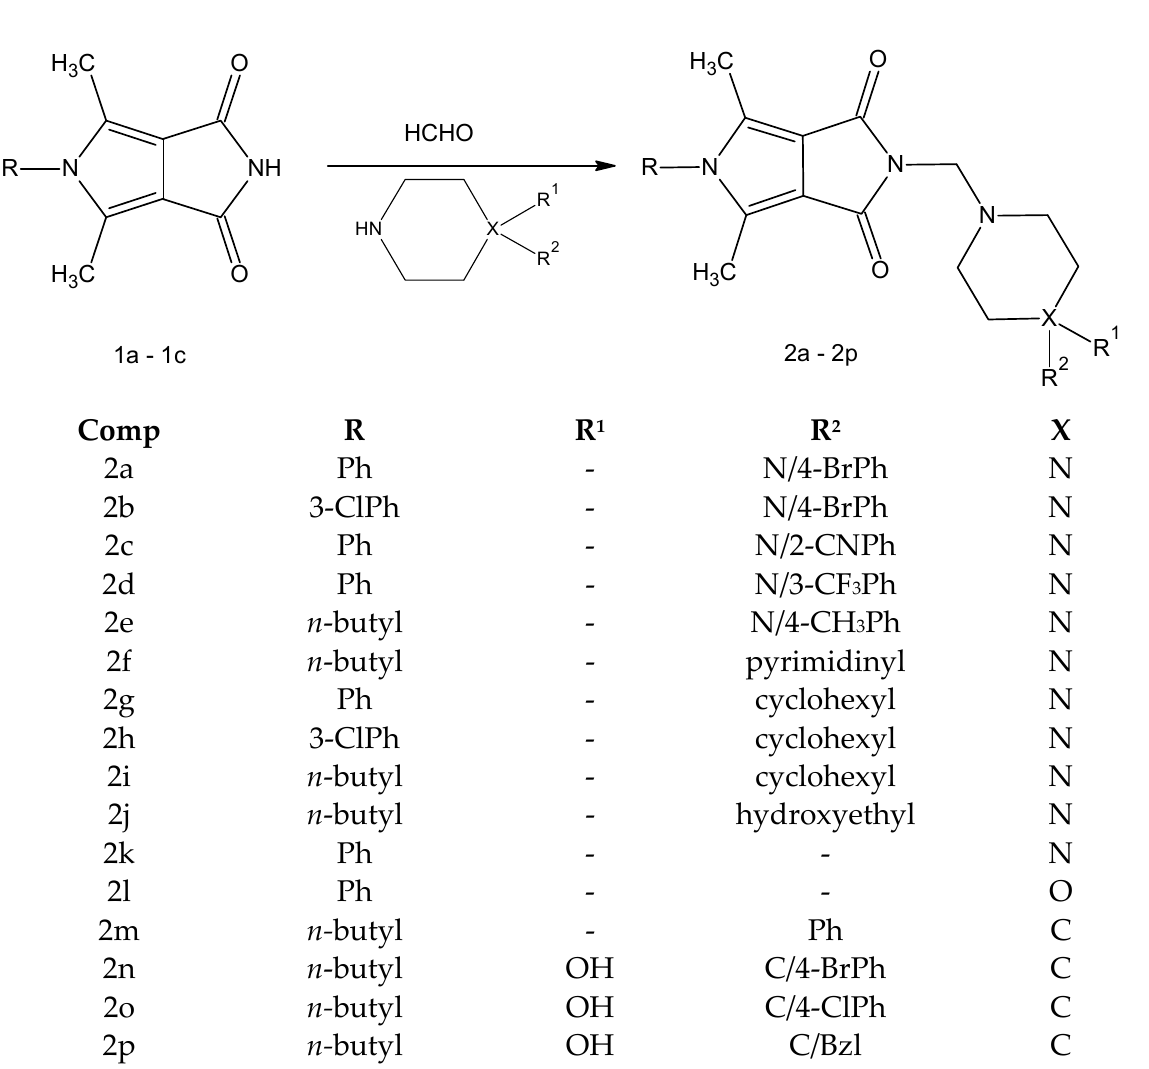
Figure 3. X-ray structures of 2h . Displacement ellipsoids are drawn at the 50% probability level. H atoms are shown as small spheres of arbitrary radii. The crystal data and structure refinement for 2h are summarized in Table 1. Table 1. Crystal and experimental data. Chemical formula: C 25 H 31 Cl N 4 O 2